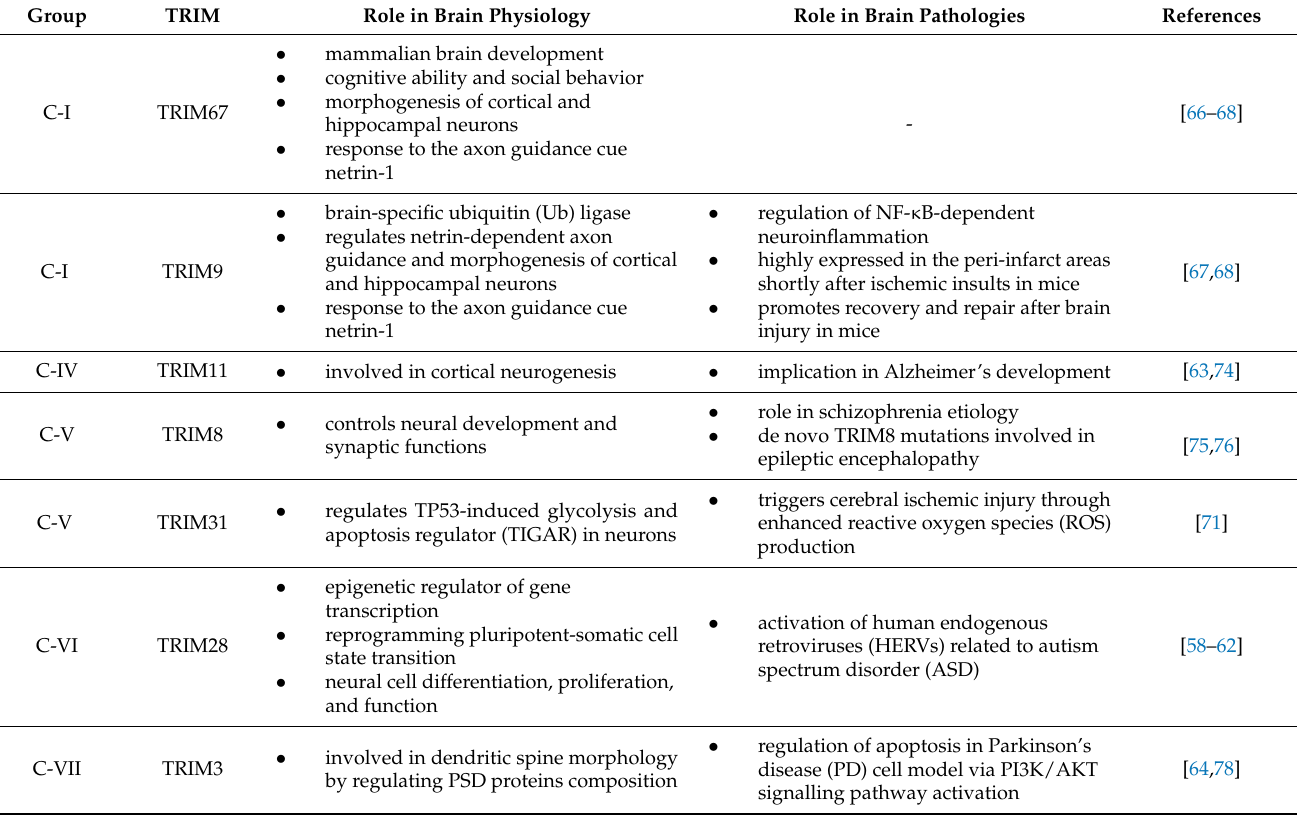
Table 1. TRIM protein family members implicated in brain physiology and related